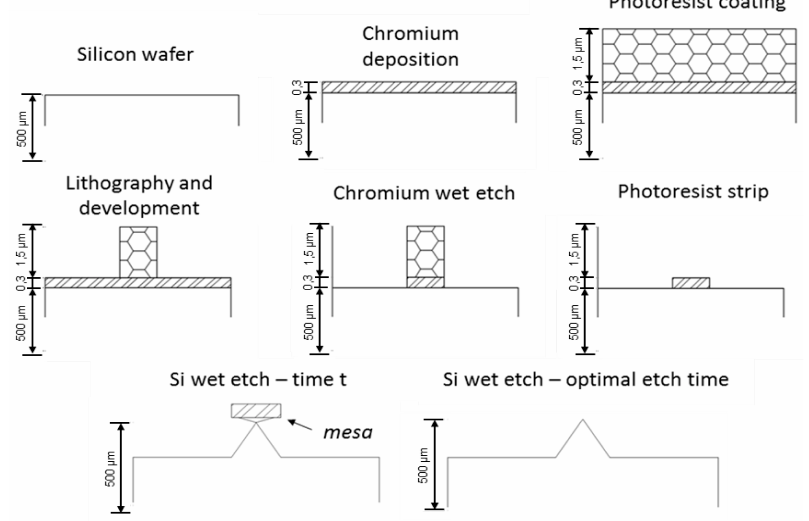
Figure 2. Schematic diagram for the manufacture process of structures through Si wet etch using a Cr mask. A perfect pyramid is obtained after the top mesa mask is released.The instant when this ocurs is defined as optimal etch time.